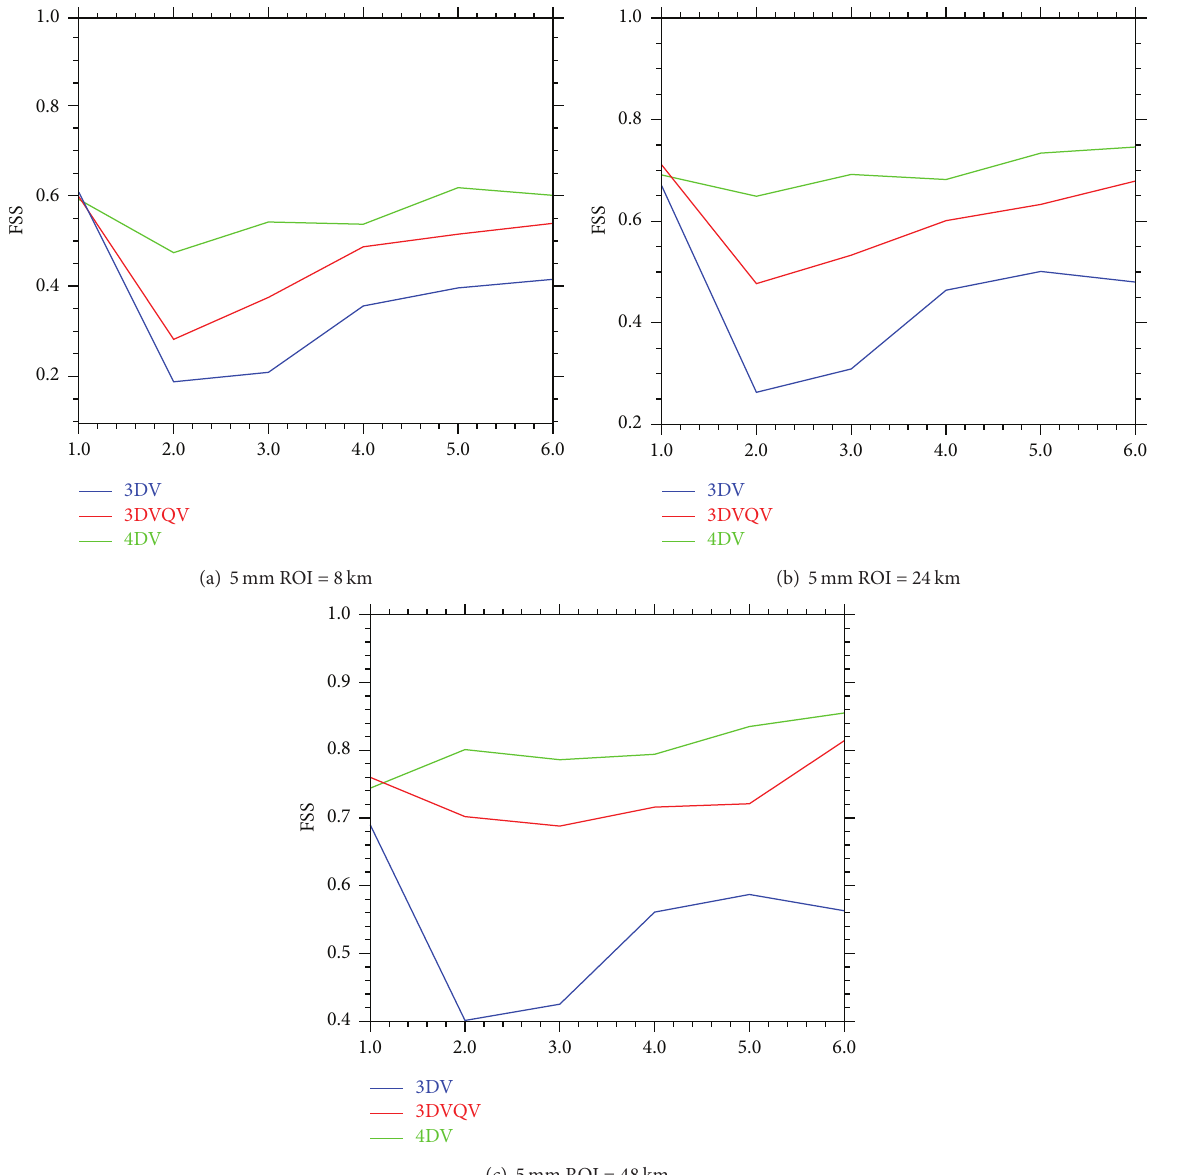
Figure 6: Fractions scale score (FSS) versus forecast hour of hourly accumulated precipitation (mmh −1 ) for the thresholds 5mm with the radius of influence (ROI) of 8km (a), 24 km (b), and (c) 48km, respectively.